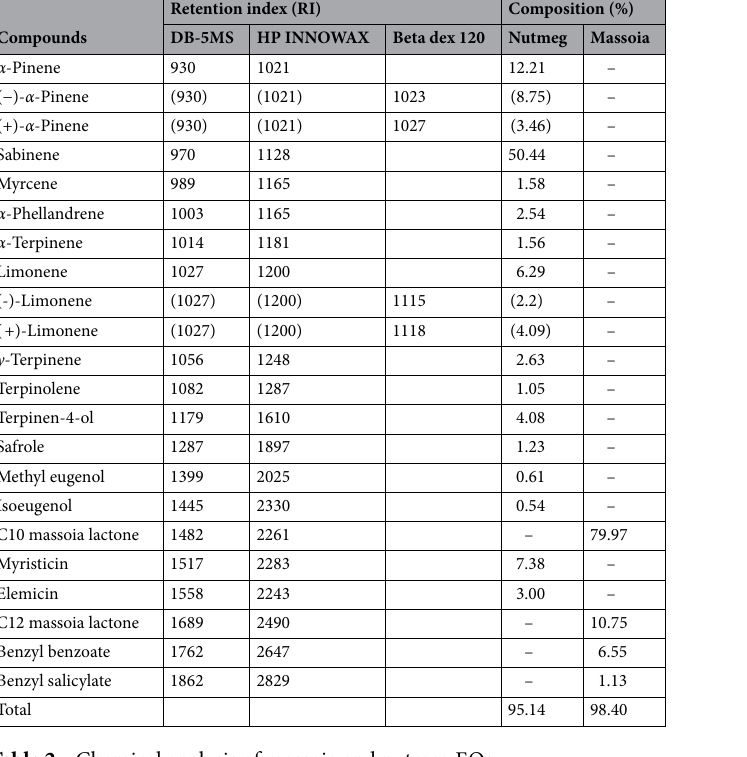
separation of the emulsion solution and the change in emulsion fraction for long-term storage at different CNC contents (Fig. 1). Phase separation of the emulsion solution was observed at 135 and 180 mg of CNC/mL massoia sion decreased after 10 days to approximately 20% for 135 and 180 mg CNC/mL massoia PEs, but no big change was shown for 270 mg CNC/mL massoia and more content (Fig. 1B). Microscopic images showed a shell structure of PEs due to the densely packed CNCs at the surface (Fig. 2A). Typically, PE size decreased as CNC content increased. The PEs ranged in size from 3 to 15 μm and the size distribution of PEs prepared at 135 and 180 mg CNC/mL massoia was wider than that of the other PEs (Fig. 2B–D). Colloidal stability of nutmeg EO PEs was achieved at a lower CNC content compared with massoia PEs (Fig. 3A). Nutmeg EO PEs were stable at 180 and 225 mg of CNC/mL nutmeg after storage for 10 days, while the emulsion fraction decreased to approximately 20% after storage for 1 day due to the phase separation of the emulsion at 45, 90, and 135 mg of CNC/mL nutmeg (Fig. 3B). Microscopic images revealed a CNC shell structure at the surface of the PEs (Fig. 4A). The PEs ranged in size from 4 to 10 μm and the size decreased as the CNC content increased (Fig. 4B–D). The massoia and nut- meg EOs encapsulated in PEs was imaged by confocal microscopy (Fig. 5). Blue fluorescence represented CNCs stained with Calcofluor white, and red fluorescence represented EOs stained with Nile red. Both massoia and nutmeg EOs were encapsulated in the CNC PEs (Fig. 5A,B). The CNCs formed a shell structure at the surface of the PEs and the EOs were contained inside the shells. The densely packed CNC shells formed a rigid structure, reducing the aggregation of particles and maintaining colloidal stability for an extended period. Larvicidal activity of CNC‑stabilized PE of massoia and nutmeg Eos. The larvicidal effect of CNC/ massoia PEs and CNC/nutmeg PEs against Ae. albopictus are shown in Table 4. Larvicidal activities of CNC/ massoia PE and CNC/nutmeg were higher than those of crude massoia and nutmeg EOs. Larvicidal activities of CNC/massoia PE, CNC/nutmeg PE, crude massoia EO, and crude nutmeg EO were 100%, 100%, 97.5% and 85.0% at 50 μg/mL, respectively. Mortality of Ae. albopictus treated with CNC PE only was 0%.